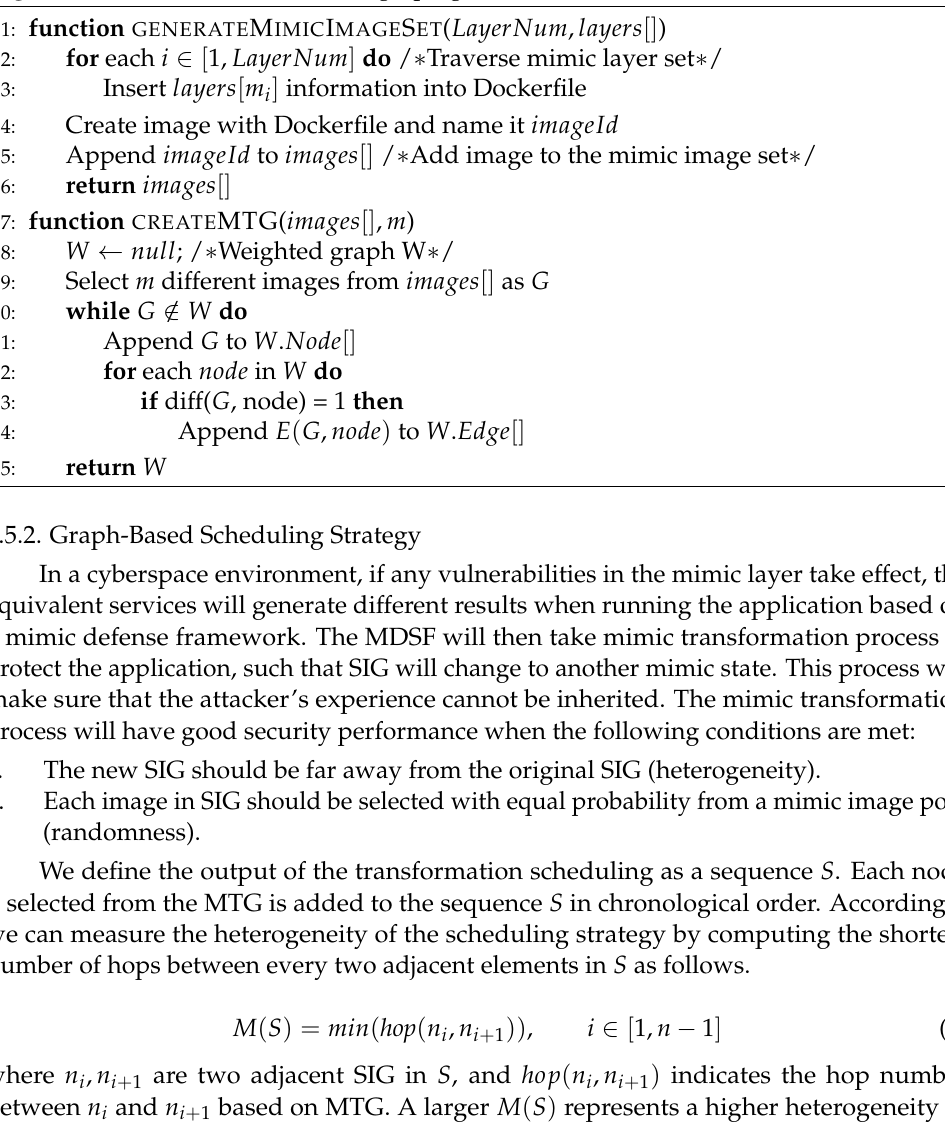
Algorithm 1 Mimic transformation graph